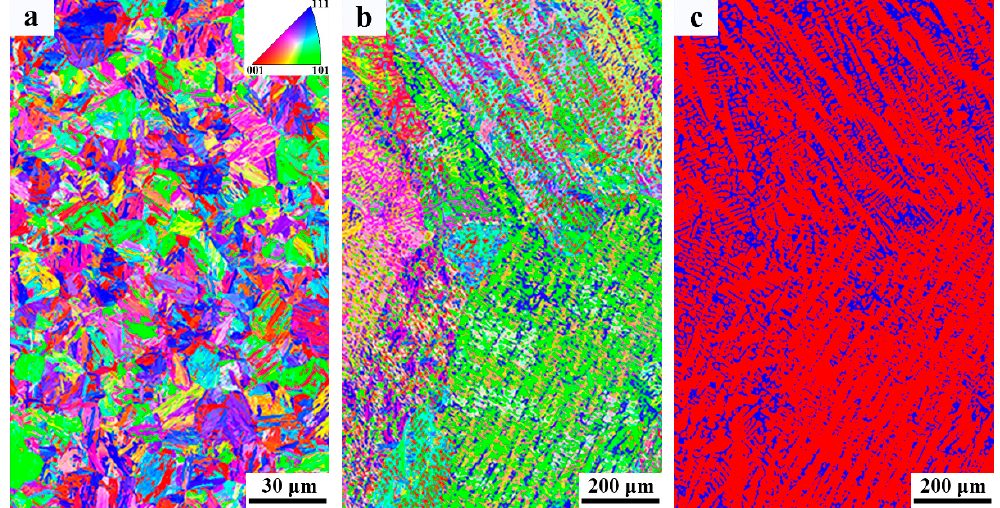
Figure 8. Electron back scattered diffraction ( EBSD) maps of both base metal and weld metal; ( a ) and ( b ) Colour inverse pole figure (IPF) for base metal and weld metal, respectively; ( c ) Phase map for weld metal where red and blue represent martensite and austenite, respectively.